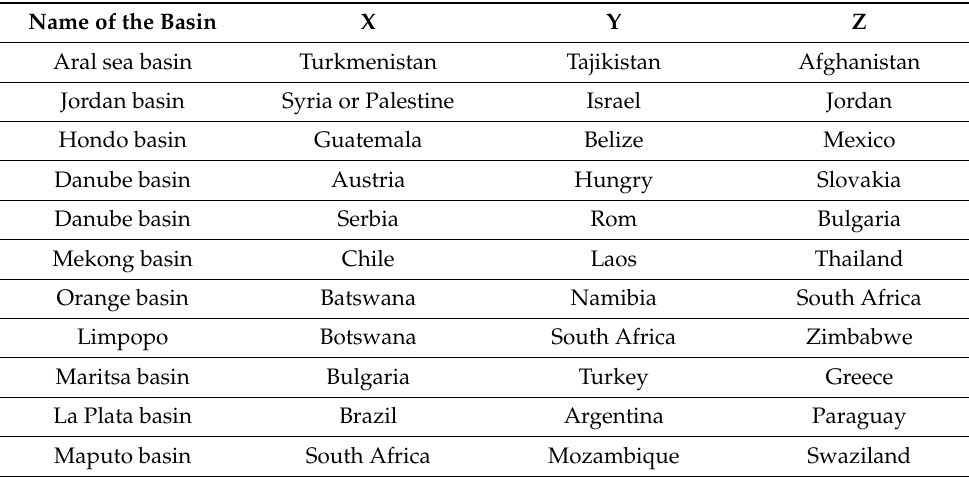
Table A3. Objective cases that can environmentally embrace